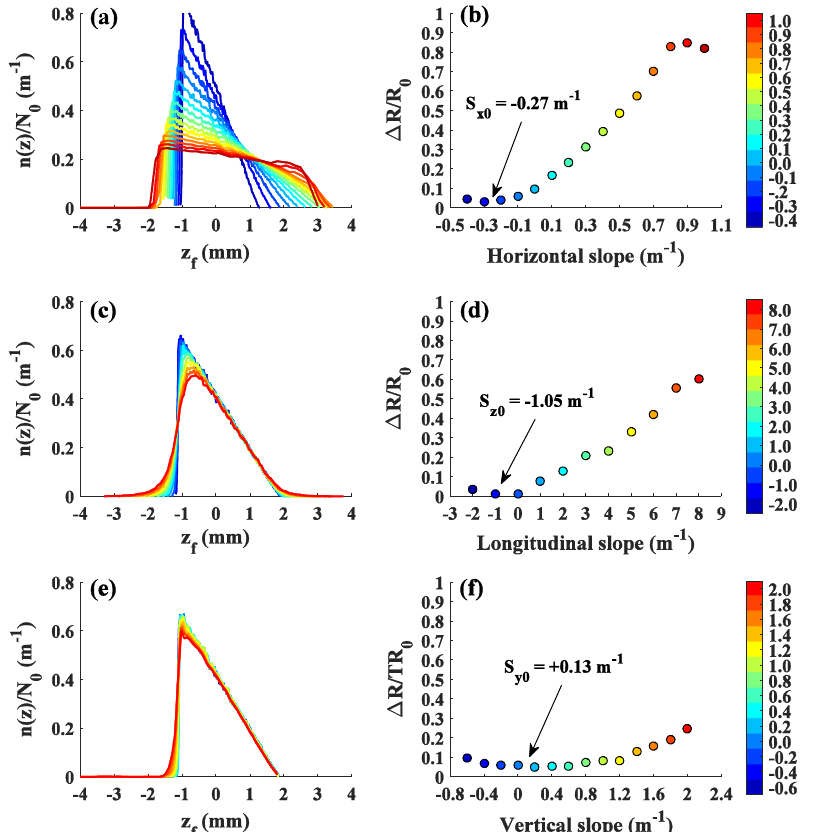
FIG. 9. Suppression of second-order effects with the slope-control method. The final longitudinal bunch shape, n ð z Þ , from GPT simulation (left column) and corresponding normalized change in the transformer ratio, Δ R=R (right column). The top row shows the effect of the horizontal slope, the middle row shows the effect of the longitudinal slope (i.e. chirp), the bottom row shows the effect of the vertical slope on n ð z Þ (left) and Δ R=R